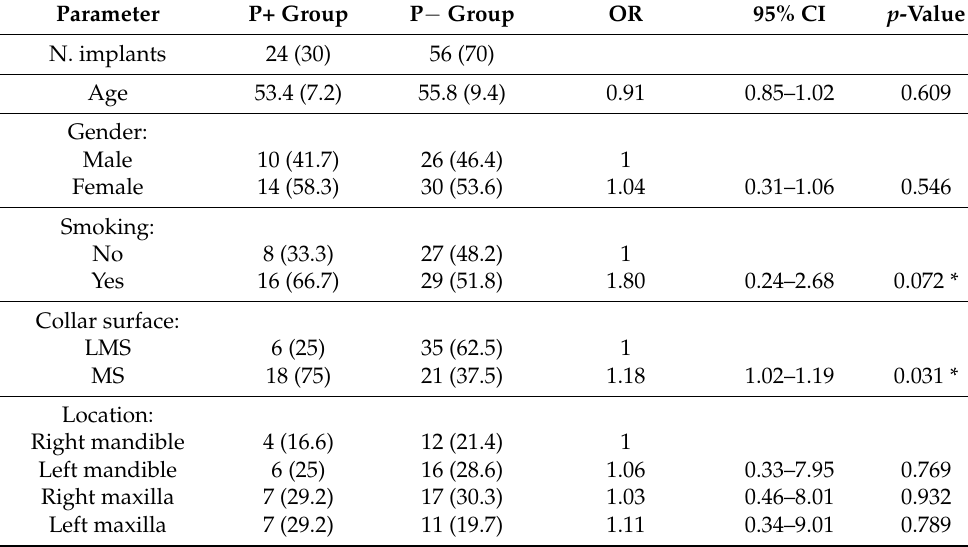
Table 3. Characteristics of patients and implants, prosthesis, and time protocols by P+/P − group: number of implants (%) or mean ± standard deviation. Results of simple binary logistic regression (odds ratio (OR) and 95% CI) using GEE